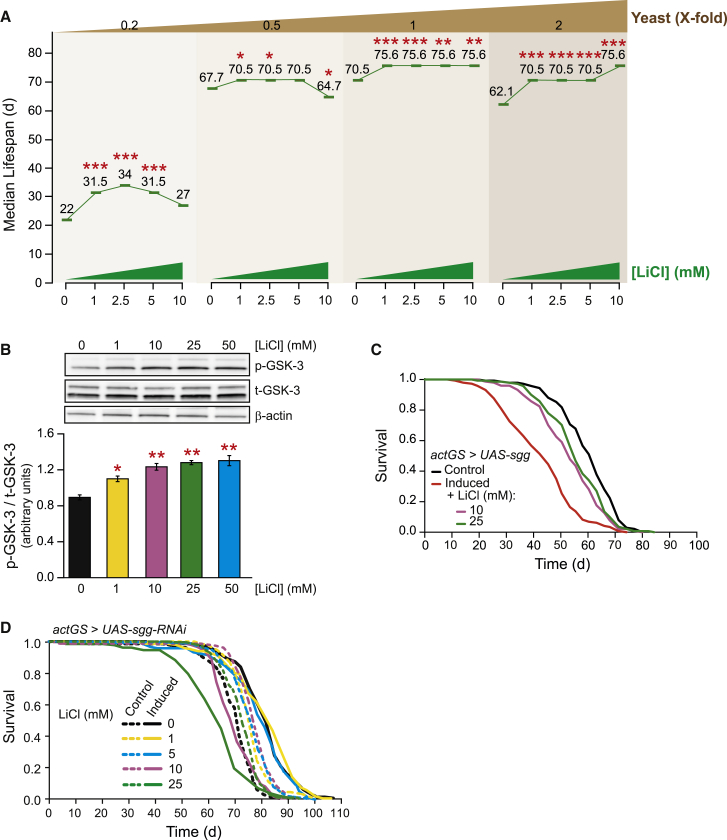
Lithium Extended Lifespan beyond Dietary Restriction by Inhibiting Sgg/GSK-3(A) Median lifespans at different lithium concentrations (0, 1, 2.5, 5, or 10 mM) are plotted for four different yeast concentrations (0.2×, 0.5×, 1.0×, and 2.0× yeast): 1–5 mM lithium extended lifespan under all dietary conditions tested. Although 10 mM lithium prolonged life at 1.0× and 2.0×, it showed no effect at 0.2× and significantly shortened lifespan at 0.5× yeast. ∗p < 0.05, ∗∗p < 0.01, ∗∗∗p < 0.001, from 0 lithium; n = 160 flies per condition. Complete survival curves are shown in Figures S2A–S2D.(B) Lithium treatment for 15 days significantly increased the inhibitory phosphorylation of Sgg/GSK-3 in a dose-dependent manner. Bars represent means of triplicates of ten flies per biological repeat ± SEM, ∗p < 0.05, ∗∗p < 0.01.(C) Ubiquitous overexpression of wild-type sgg significantly shortened lifespan (p < 0.001) and this was partially rescued by lithium treatment at two concentrations (10 and 25 mM; p < 0.001). See Figure S2E for the interaction of sgg(S9A) and lithium treatment on lifespan.(D) Ubiquitous RNAi-mediated downregulation of sgg extended lifespan (p < 0.001) and no further extension occurred when the flies were treated with 1 or 5 mM lithium (p > 0.05), whereas 10 mM lithium treatment restored the lifespan to control levels (p > 0.05), and 25 mM was significantly toxic (p > 0.05). See Figure S2F for lifespan extension obtained with an independent RNAi line.